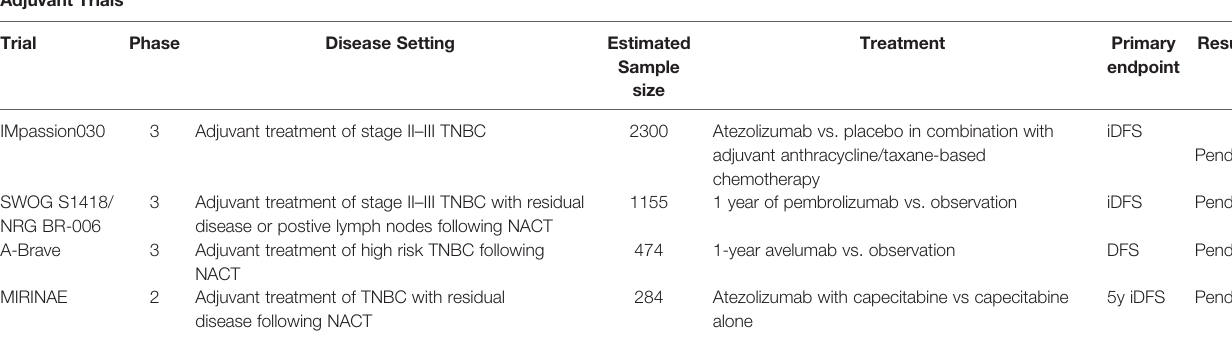
TABLE 9 | Major adjuvant trials that include immune checkpoint inhibitors in patients with stage I – III TNBC. Adjuvant